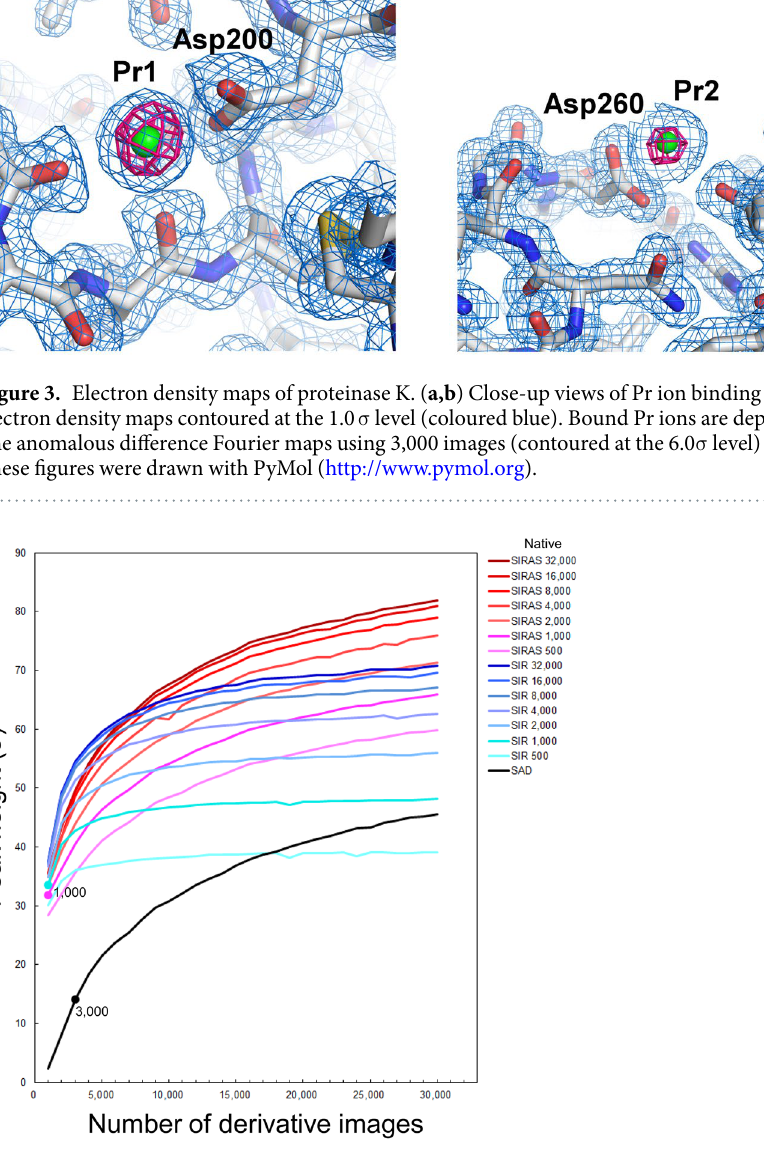
Figure 4. Improvement of anomalous difference peak heights with the number of derivative images. The plot of the sum of the anomalous peak heights from two Pr atoms. SAD, SIR and SIRAS phasing are shown in the black, blue and red lines, respectively. For SIR and SIRAS phasing, the number of native images were varied from 500 to 32,000. Filled circles indicate the minimum number of derivative images necessary for each phasing method and number of native